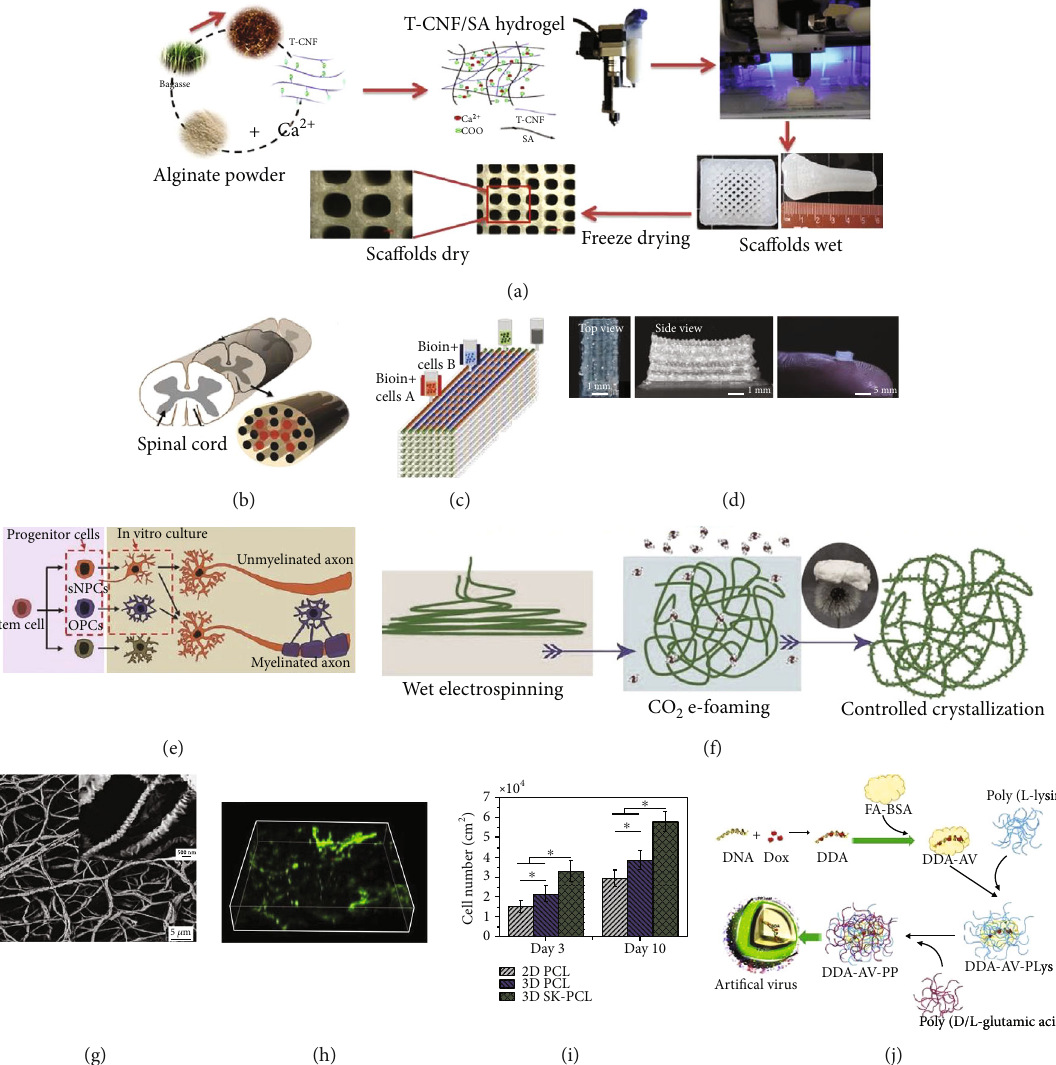
Figure 9: Bioinspired functional materials with bioactivity. (a) A fabrication process for 3D printing sca ff olds from TEMPO-oxidized cellulose nano fi brils/sodium alginate hydrogels. (b) A schematic of the spinal cord and a design for a 3D bioprinted multichannel sca ff old that models the spinal cord. (c) A schematic overview of the 3D bioprinting process. (d) The as-prepared sca ff olds. (e) A schematic of the induced pluripotent stem cell reprogramming and di ff erentiation into sNPCs or OPCs. (f) A schematic illustration of the bioinspired nano fi ber sca ff old preparation process. (g) The morphology of 3D SK-PCL nano fi bers at di ff erent magni fi cations. (h) Fluorescent images of live/dead assay results for human fi broblasts cultured on an as-prepared sca ff old. (i) Cell proliferation results from an MTS assay of human fi broblast cells cultured on di ff erent materials for 3 days and 10 days. (j) A schematic representation of the formation of arti fi cial viruses